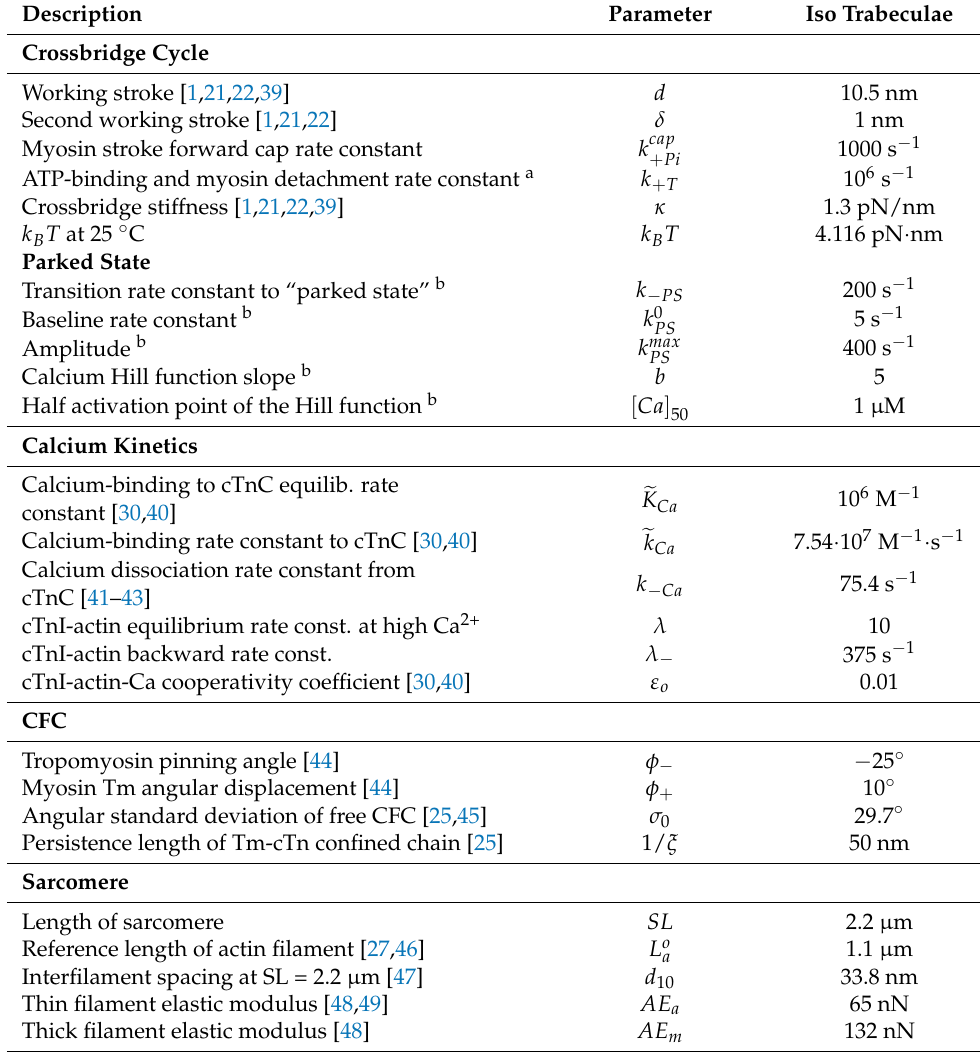
Table 1. Common MUSICO parameters for all simulations of twitch contractions in intact trabeculae at fixed lengths and a temperature of 25 ◦